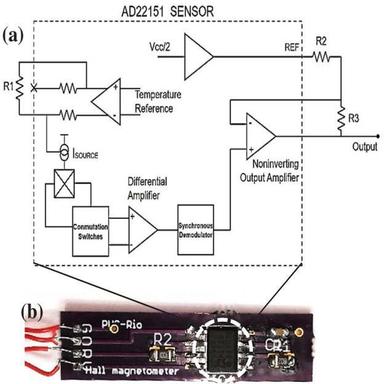
(a) AD22151 internal schematic; (b) Picture of the circuit board.